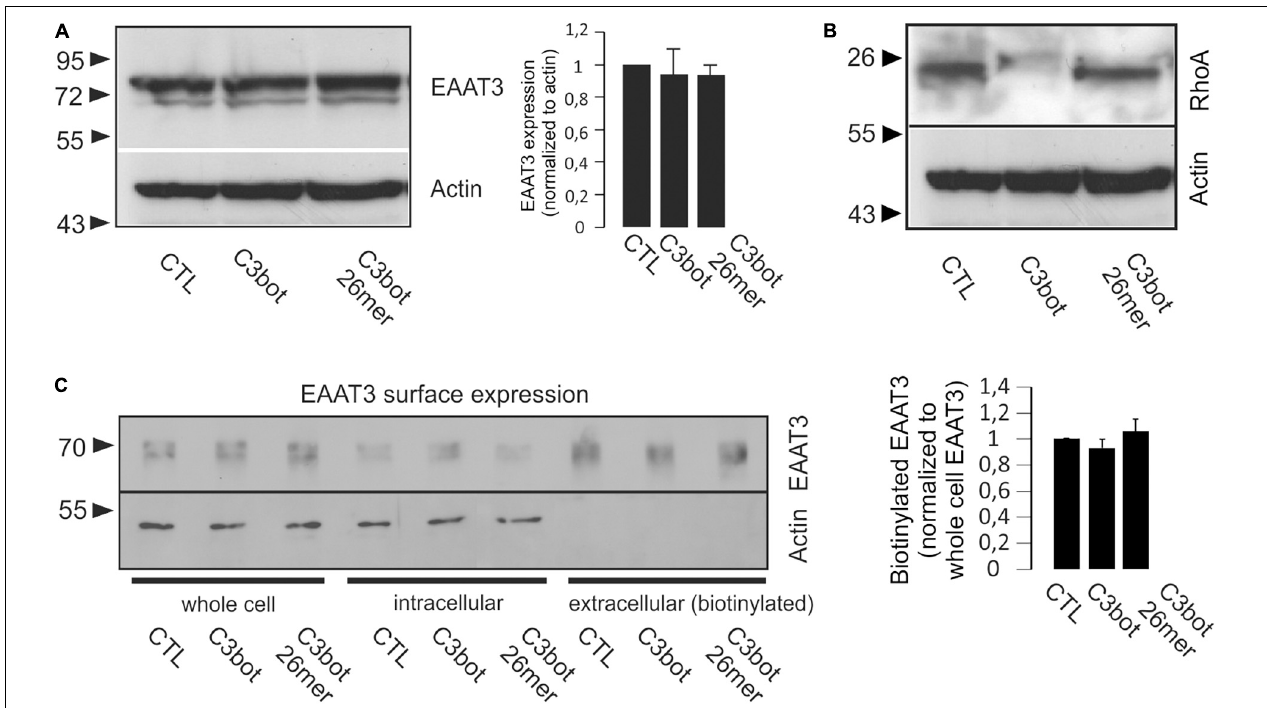
FIGURE 4 | Treatment with C3bot or C3bot 26mer does not alter protein expression and surface location of EAAT3. (A) Western blot analysis of EAAT3 expression following treatment of hippocampal neurons for 3 days with 300 nM of C3bot or C3bot 26mer. Quantification revealed that following either treatment, protein levels of EAAT3 remained unchanged after incubation with the C3 preparations. Values are expressed as means ± SEM from three independent experiments. (B) ADP-ribosylation of RhoA by C3bot. Homogenates of hippocampal neurons treated as above were subjected to Western blotting analysis and stained for RhoA. Actin served as loading control. Cells treated with C3bot exhibited a complete shift of RhoA to higher molecular weight form indicative of quantitative ADP-ribosylation by enzyme competent C3bot. Also, degradation of inactivate RhoA was observed. (C) Surface expression of EAAT3 was analyzed by biotinylation assays. Hippocampal neurons treated with C3bot or C3bot 26mer as above were subjected to biotinylation and subsequent subcellular fractionation into intracellular and extracellular (biotinylated) compartments. Quantification of EAAT3 in the pelleted extracellular fraction revealed no significant changes in surface expression of the transporter. Values are expressed as means ± SEM from three independent